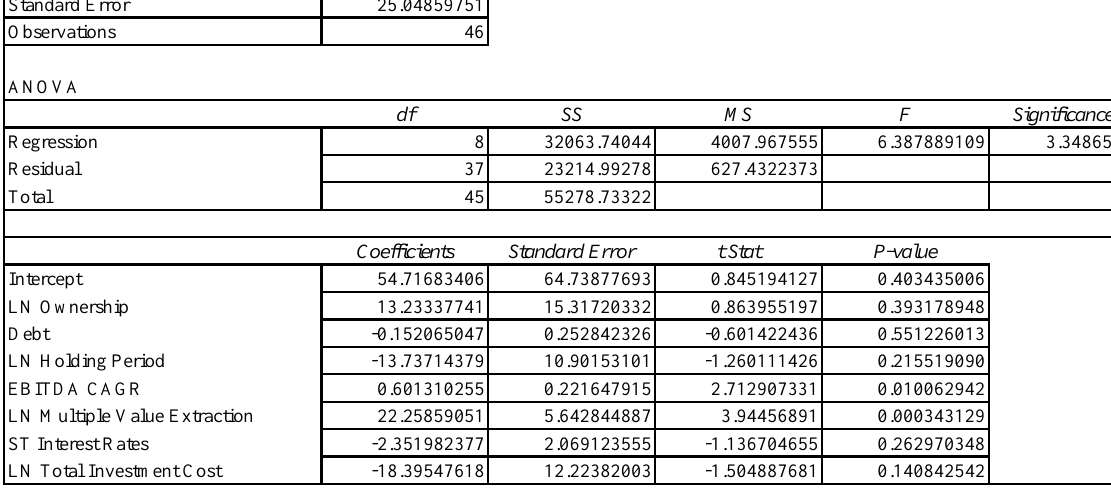
Table 2: Correlation matrix